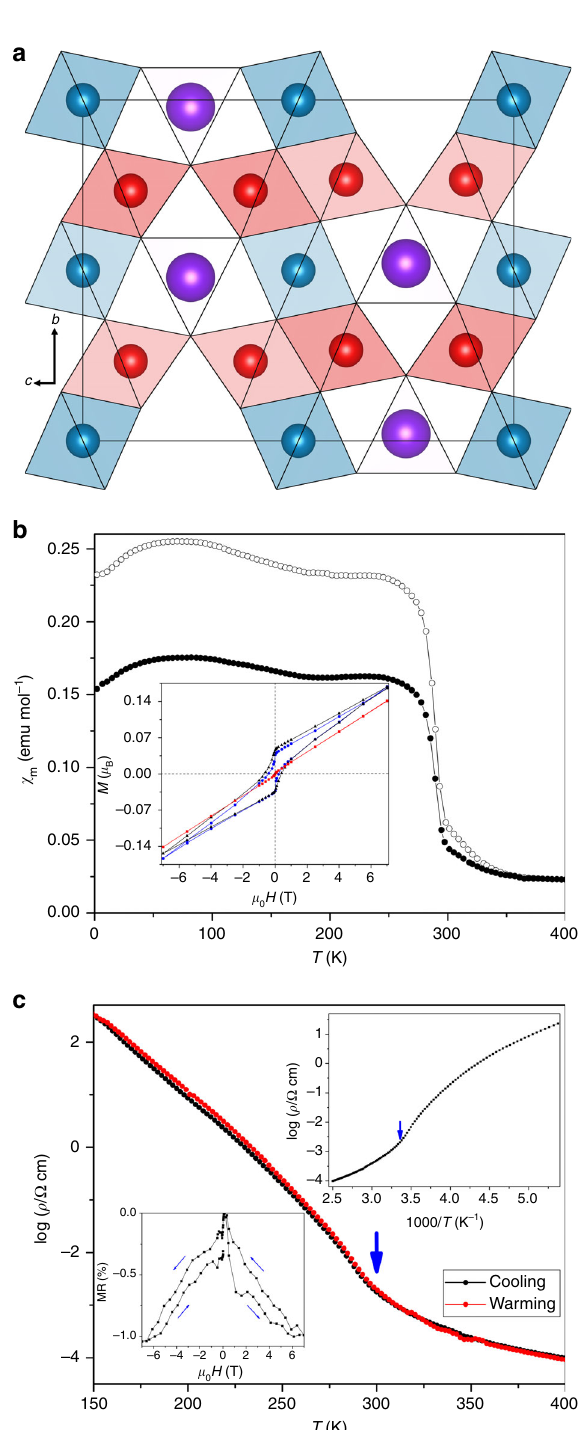
Fig. 1 Crystal structure and magnetisation studies of CaFe 3 O 5 . a Polyhedral projection of the CaFe 3 O 5 structure showing FeO 6 octahedra in red/blue for symmetry inequivalent Fe1/Fe2 sites, and Ca within trigonal prismatic tunnels in purple. b ZFC (closed symbols) and FC (open symbols) magnetic susceptibilities for CaFe 3 O 5 , with insert showing magnetisation- fi eld measurements at 2, 230 and 300 K (blue, black and red points respectively). c Log 10 plot of the electrical resistivity of a sintered pellet of CaFe 3 O 5 against temperature on cooling and warming, with the discontinuity at 302 K marked. Inset in the top right shows the plot against reciprocal temperature with a change in activation energy from 0.61 eV below T M to 0.26eV above the transition. Inset in lower left displays the magnetoresistance MR at 200